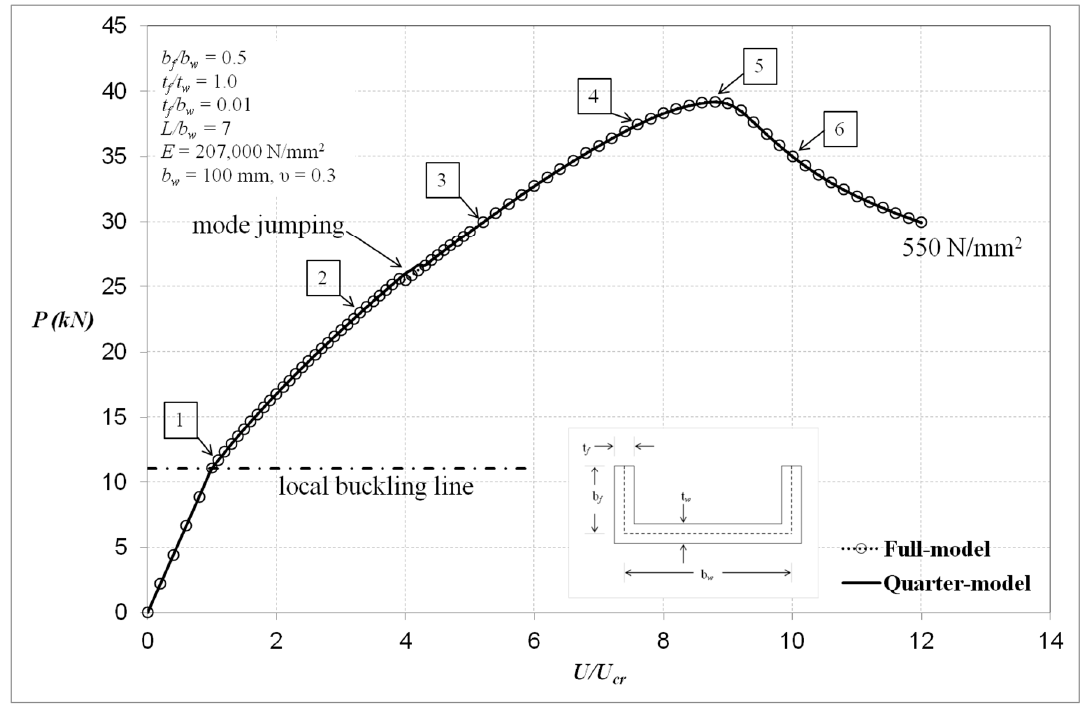
Figure 11. Load–end compression curves with yield stress level of 550 N/mm 2.